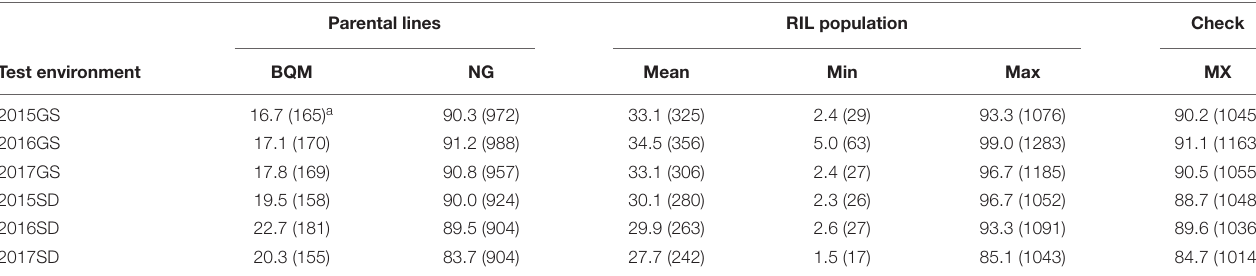
TABLE 2 | Leaf rust severities of the parental wheat lines Bai Qimai (BQM) and Nugaines (NG), the check Mingxian169 (MX), and the recombinant inbred line (RIL) population of NG × BQM in field trials under natural infections of Puccinia triticina during 2015–2017 in Gansu (2015GS, 2016GS, and 2017GS) and Shandong (2015SD, 2016SD, and 2017SD). Parental lines RIL